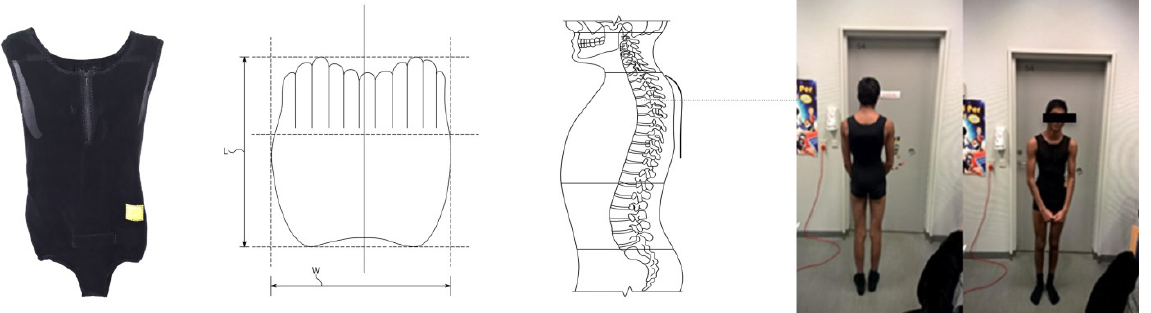
Figure 1. The ‘suit’ of the Spinaposture brace ( left ), a schematic diagram of the ’shield with fingers’ and placement of the shield ( middle ) and the Spinaposture brace© worn by a subject ( right ).